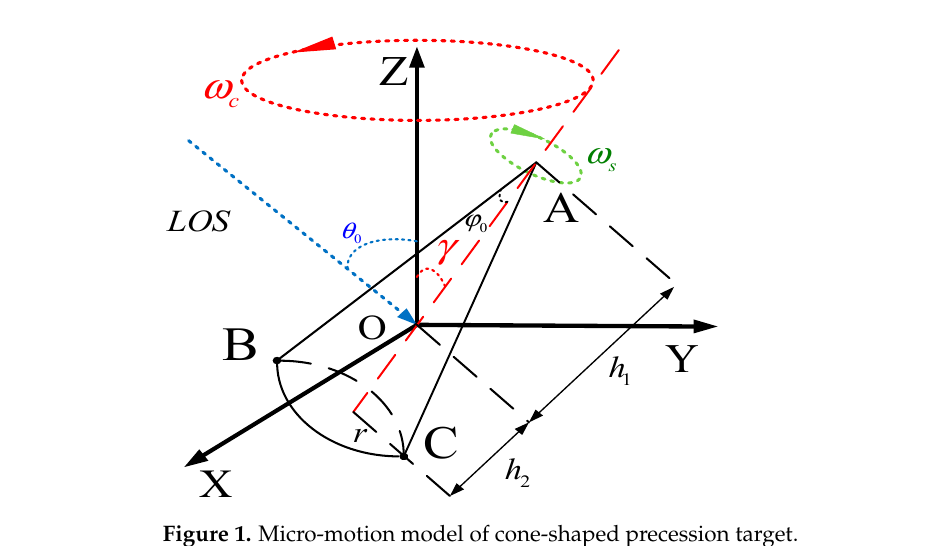
Figure 1. Micro-motion model of cone-shaped precession target.